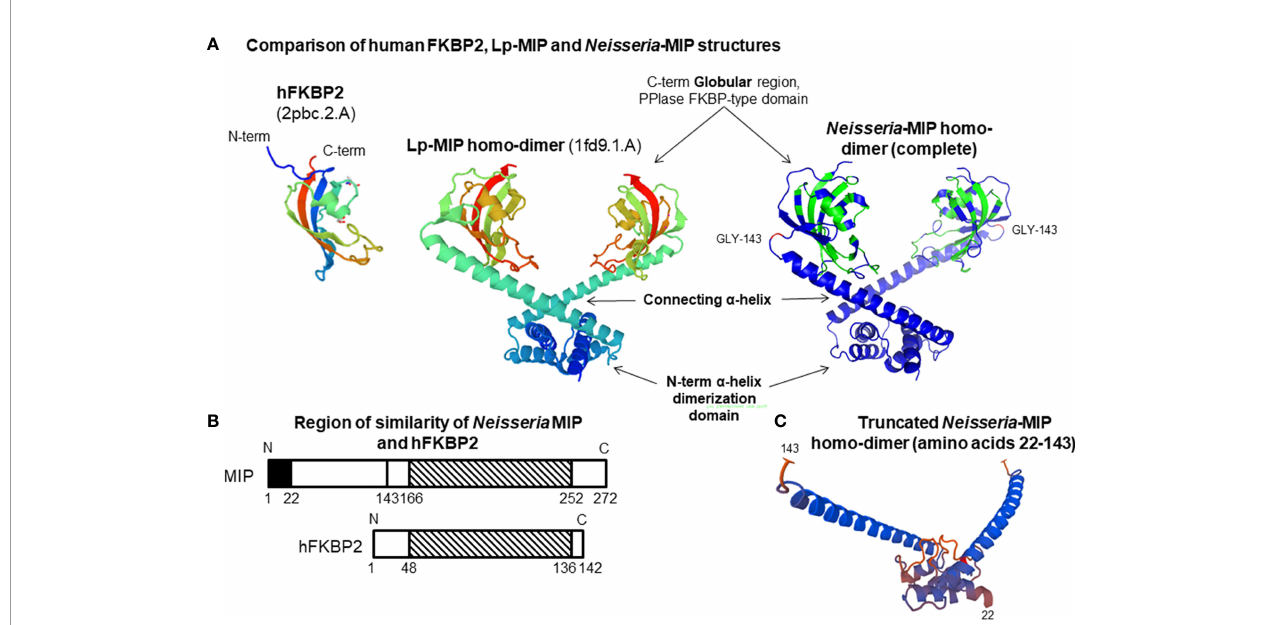
FIGURE 1 | (A) Comparison of human FKBP2, Legionella pneumophila (Lp)-MIP and Neisseria -MIP structures. The Neisseria -MIP model is based on the crystal structure of Lp-MIP and consists of 3 domains as marked. Two monomers assemble to form a homo-dimer that associated with the bacterial OM. The structure of the human FKBP2 PPIase globular protein is shown for comparison. (B) Cartoon showing the overlapping region of similarity between Neisseria MIP and human FKBP2 protein. Similarity is within the striped C- terminal region. (C) Structure of the truncated MIP homo-dimer. The sequence of amino acids 22-143 located within the N- terminal region after removal of the globular regions that contain FKBP activity. Adapted from our fi gures published by Humbert et al. (2015) and Bielecka et al.